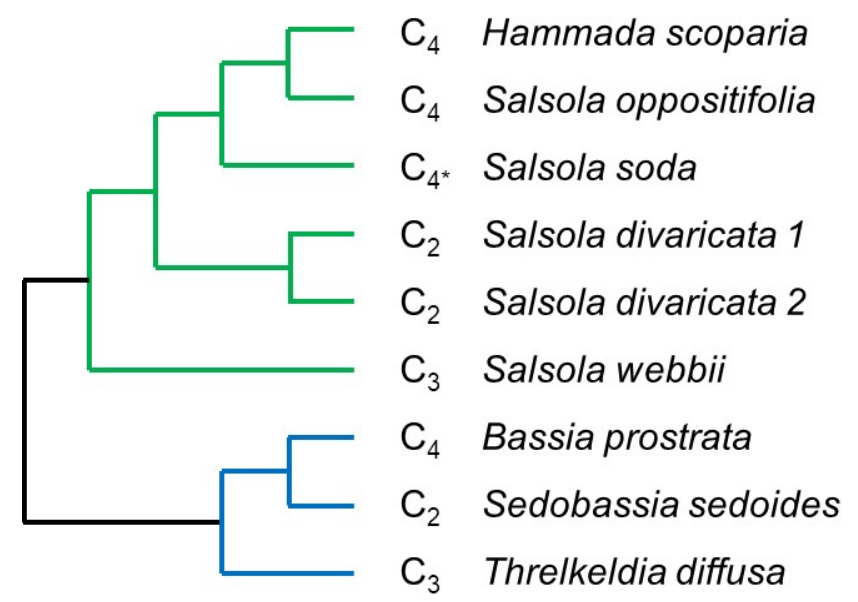
Figure 4. Phylogenetic relationships between species of the current study. The photosynthetic type is indicated. C 4 *, species with C 4 photosynthesis in leaves/assimilating shoots but C 3 in cotyledons. Green colour represents Salsoleae ; blue represents Camphorosmeae .